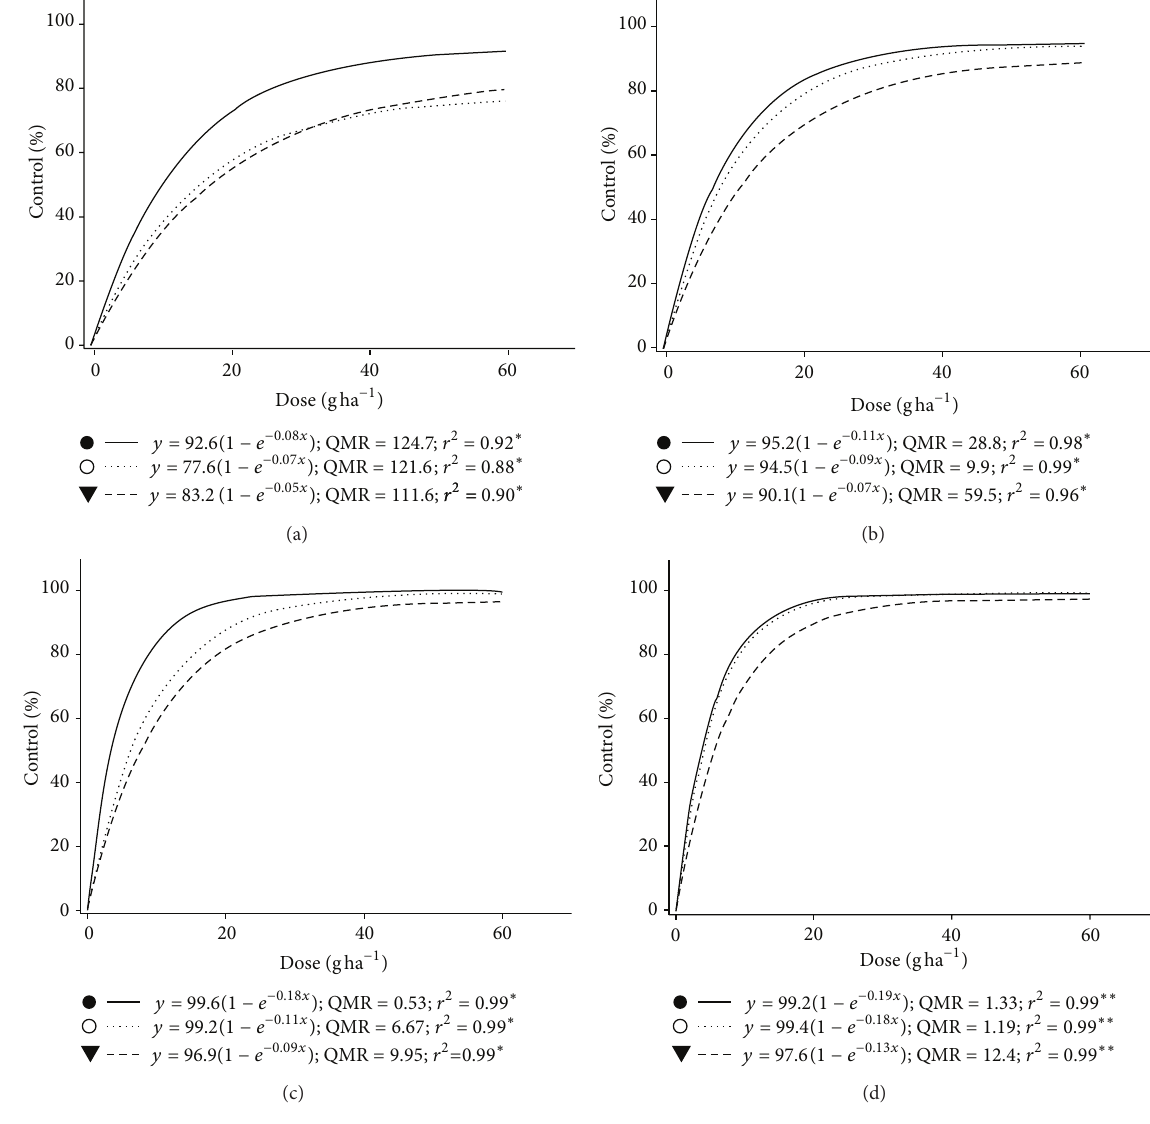
Figure 2: Control of Echinochloa sp. in irrigated rice, evaluated at 10DAT (a), 20DAT (b), 30DAT (c), and 65 DAT (d), depending on the starting times of irrigation ( ∙ 1DAT, O 15 DAT, and 󳶃 30DAT), penoxsulam rates, and time of application late, Rio Grande, RS ( 𝑟 2 : coefficient of determination; QMR: meansquare; ∗ significant, a 𝑃 ≤ 0,05